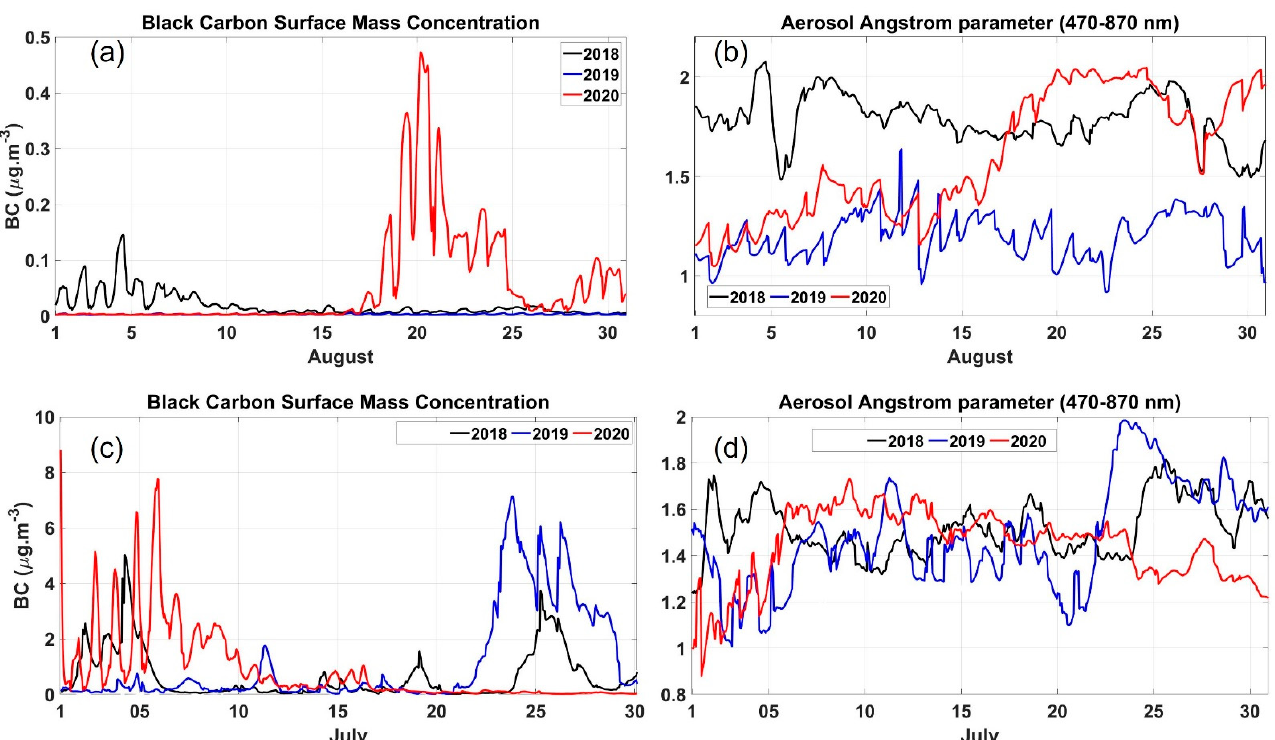
Figure 3. California ( a ) hourly averaged BC surface concentration for the month of August in the 2018, 2019 and 2020 period. ( b ) Daily Aerosol Angstrom parameter for the month of August in the 2018, 2019 and 2020 period. Krasnoyarsk Krai ( c ) Hourly averaged BC surface concentration for the month of July in the 2018, 2019 and 2020 period. ( d ) Daily Aerosol Angstrom parameter for the month of July in the 2018, 2019 and 2020 period.